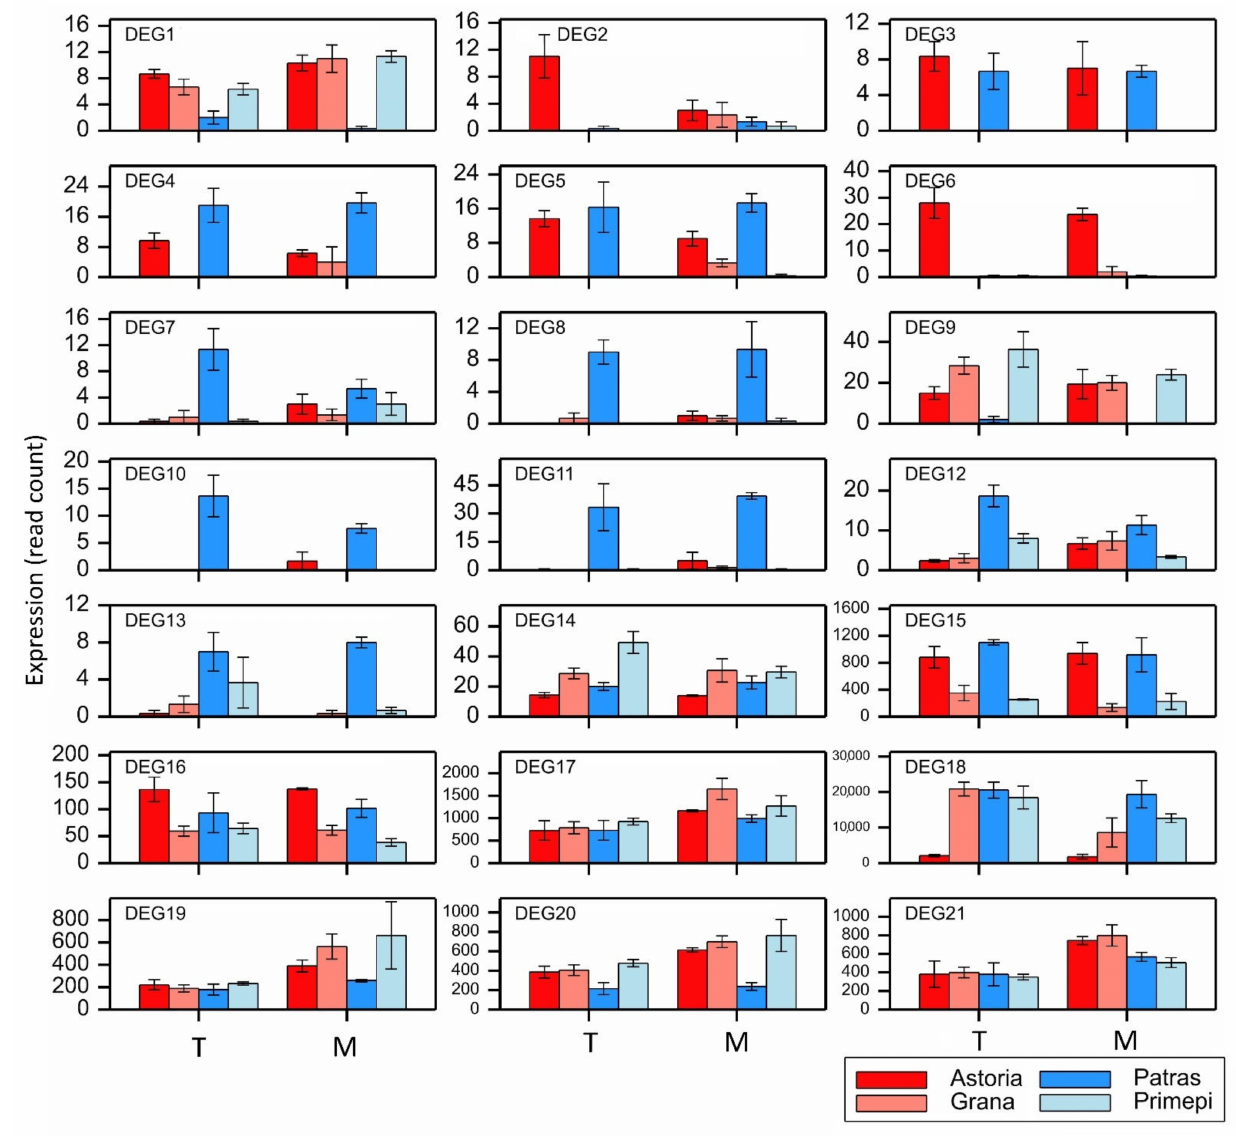
Figure 2. In silico expression profiles of 21 DEGs identified as potential Rf candidate genes. Data are presented as the mean values of the NGS read counts over the replicates, with error bars corresponding to the standard error of the